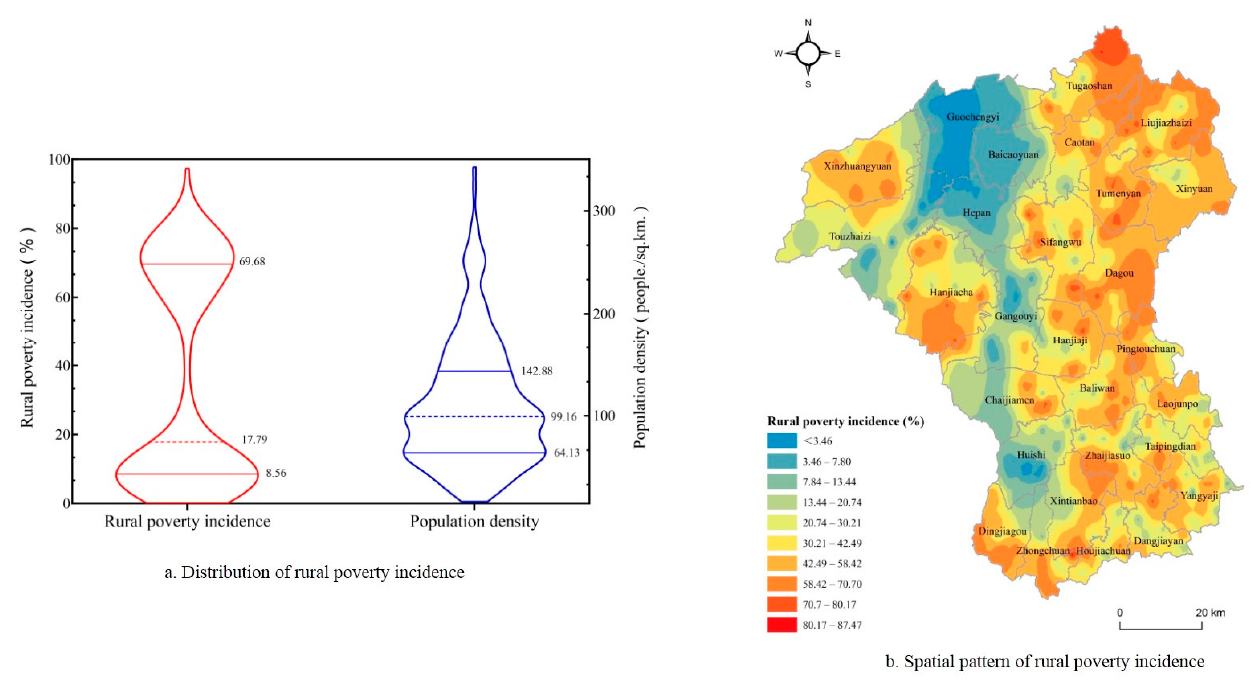
Figure 3. The distribution and spatial pattern of RPI in